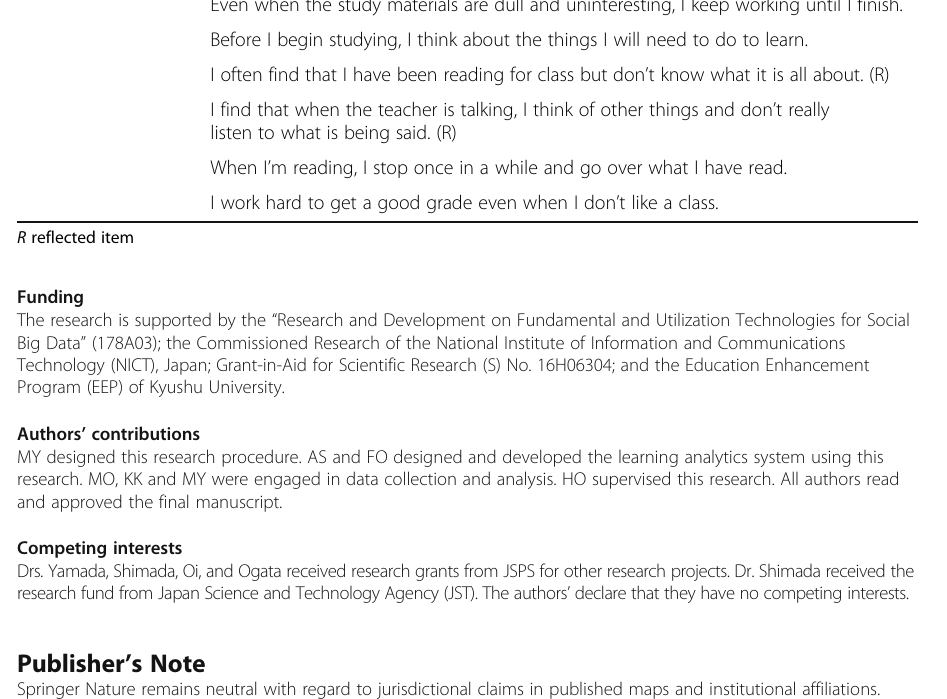
Table 7 Motivated strategies and learning questionnaire (Pintrich and DeGroot 1990) (Continued) I work on practice exercises and answer end of chapter questions even when I don ’ t have to. Even when the study materials are dull and uninteresting, I keep working until I